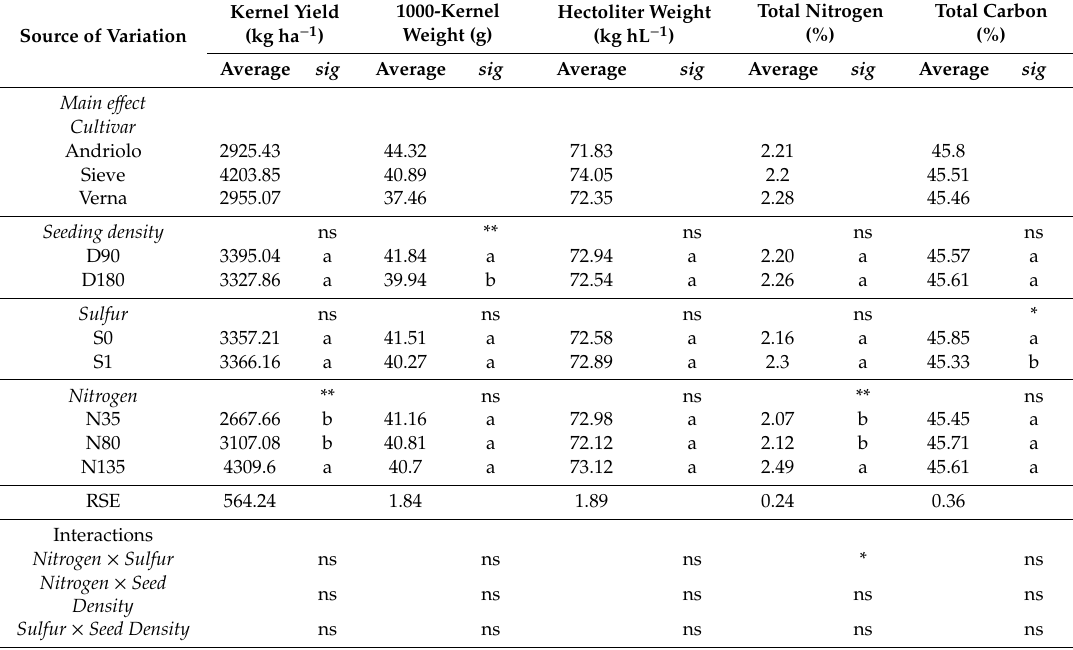
Table 1. Mean of kernel quality parameter results by nitrogen fertilization, sulfur fertilization, seed density, cultivar and first order interaction. The sig columns report the ANOVA results (* = 0.05, ** = 0.01, *** = 0.001, ns = not significant), while lowercase letters represent the Tukey HSD post hoc test results. RSE = residual standard